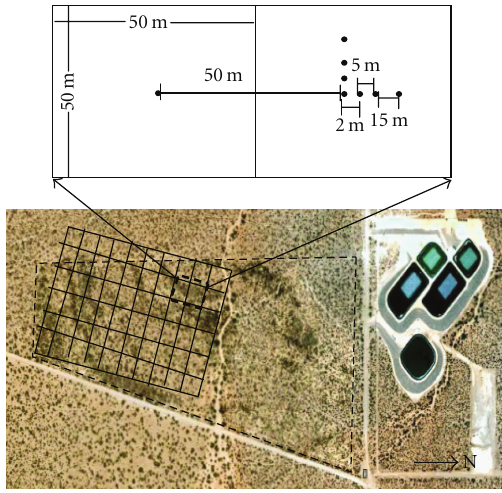
Figure 1: Aerial photograph of West Mesa land application sites, showing vertical, horizontal grid lines, sampling distances on 50 × 50m grid and other lag samples on 2 m, 5m, and 15 m, distances (not in scale).